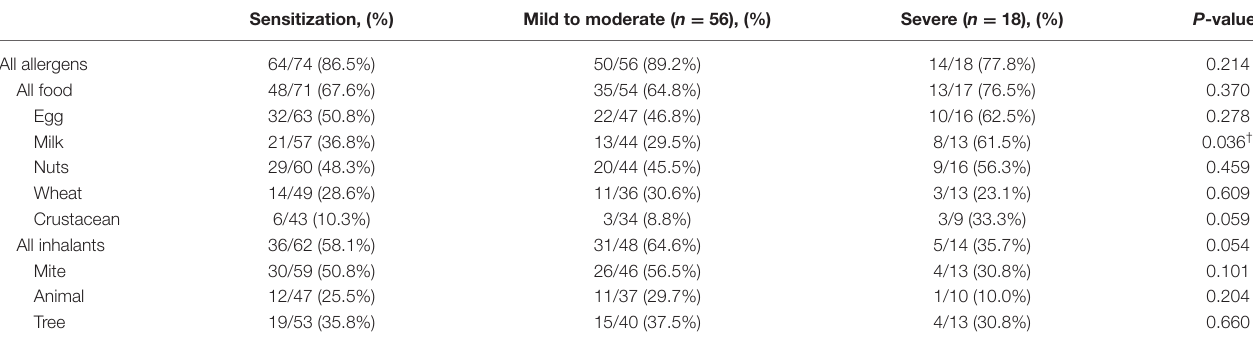
TABLE 2 | Allergen sensitization rate of the allergy tests and the comparison with the severity of anaphylaxis (mild to moderate vs. severe) ( n = 74). Sensitization, (%) Mild to moderate ( n = 56), (%) Severe ( n = 18), (%) P -value* All allergens